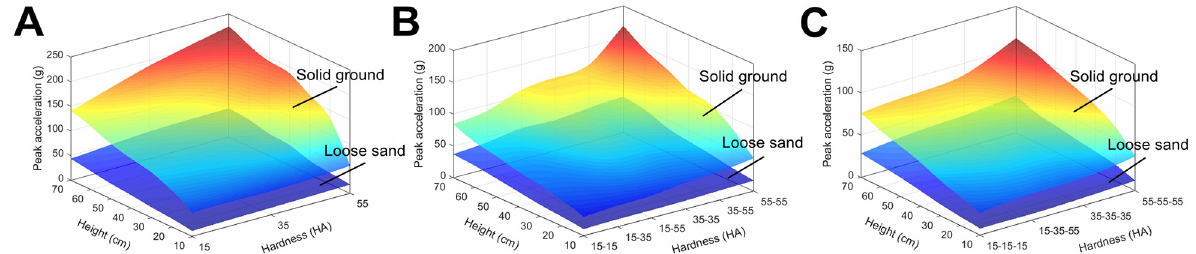
Fig 7. Results of impact tests. Comparisons of cushioning performances among bio-inspired feet assembled with (A) single-layer, (B) double-layer and (C) three-layer silicon rubbers on loose sand and solid ground.